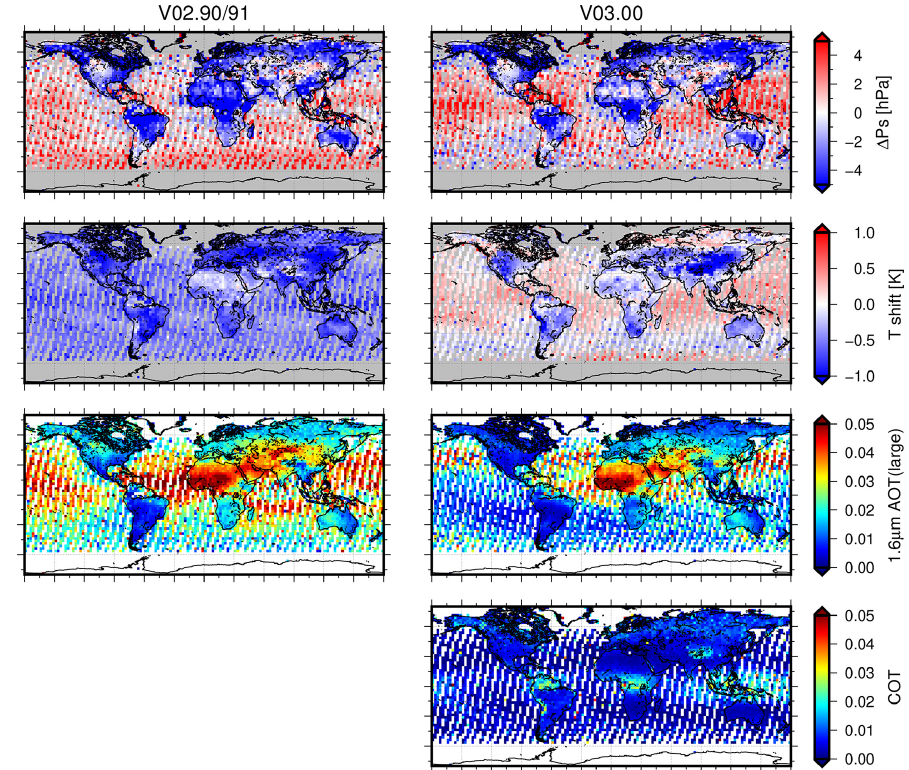
Figure 9. Distributions of the averaged (cid:49)P s , T shift, large particle AOT at 1.6µm, and COT at 0.55µm from V02.90/91 and V03.00. COT is obtainable only from V03.